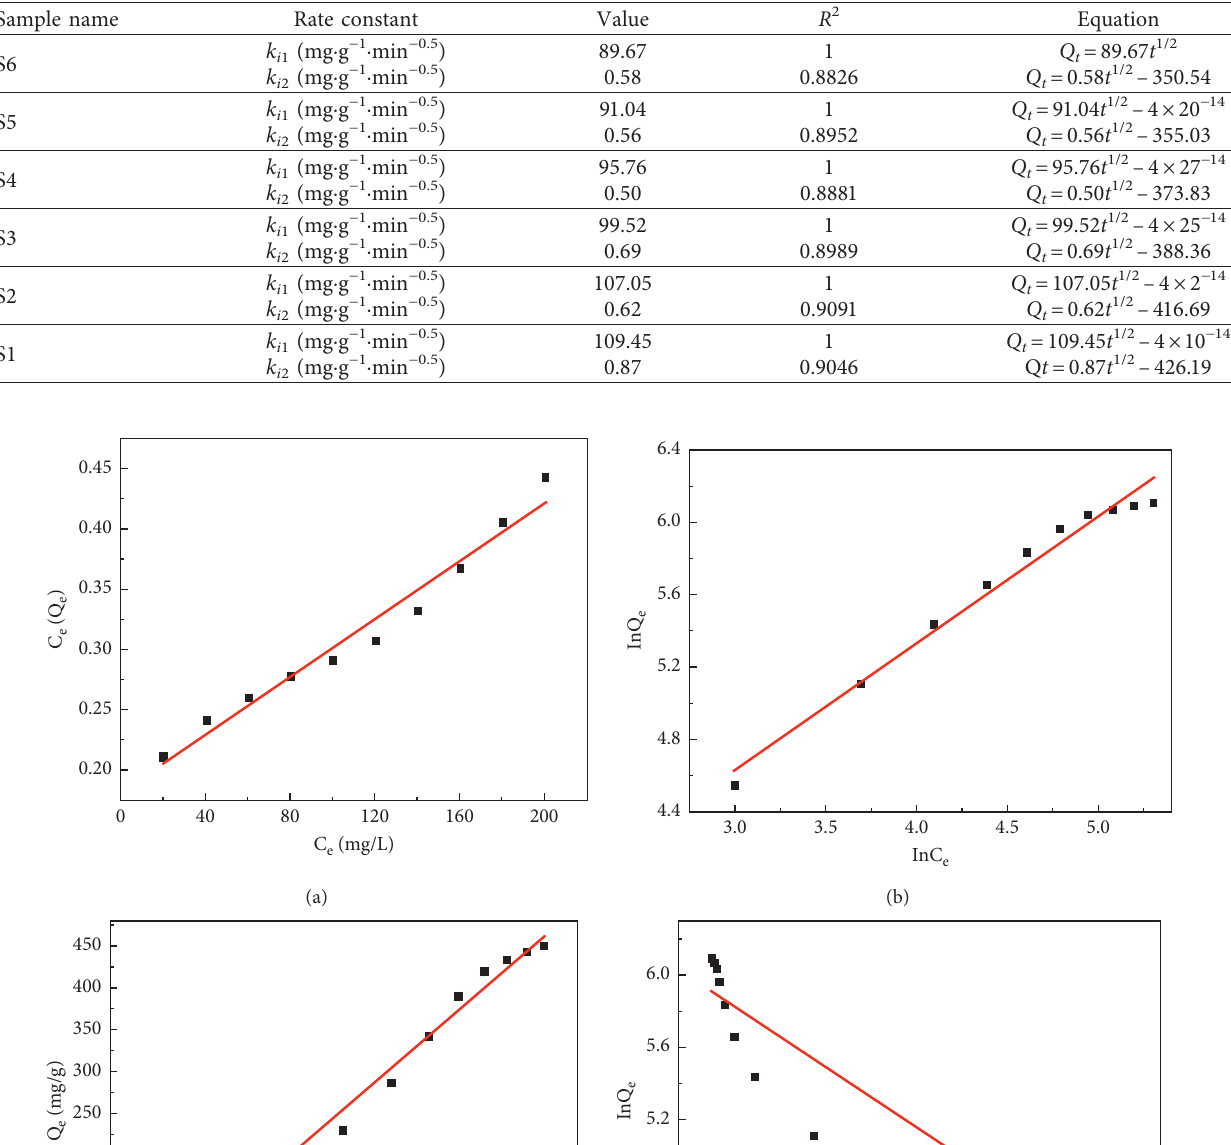
3 O 4 /PPy nanotubes.